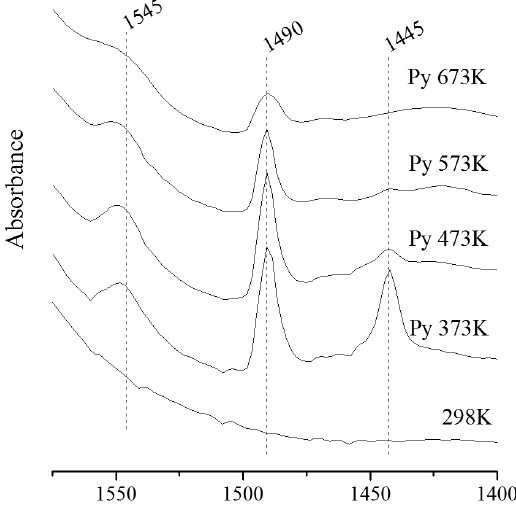
Figure 2. FT-IR spectra of pyridine adsorbed on the sample LaAl 12